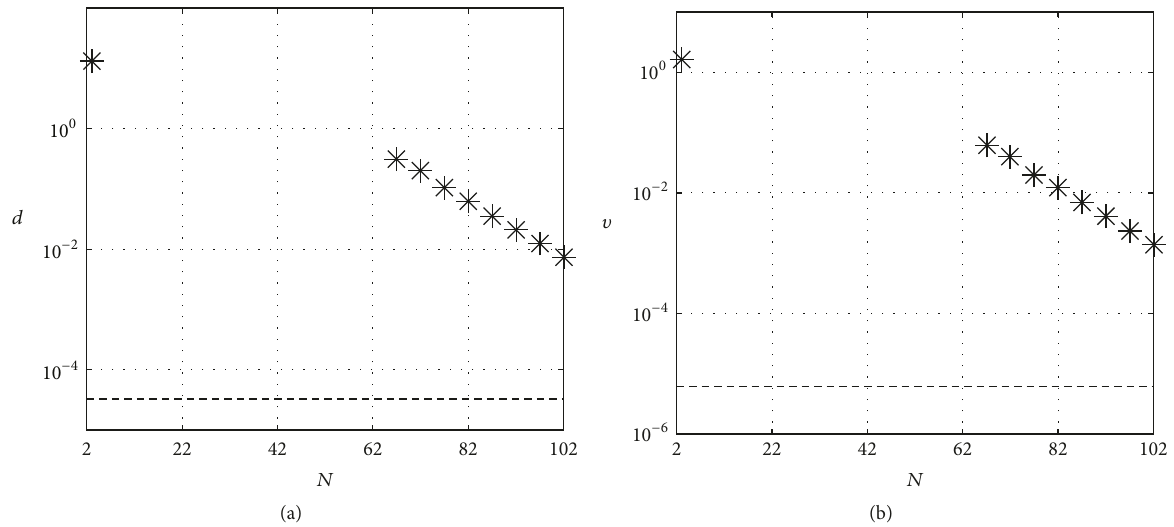
Figure 9: Indexes (a) 𝑑 and (b) 𝜐 when applying aPBC to TUPO1 for different 𝑁 with 𝑘 = 0.25 and 𝑘 𝑜 = 10 . Bottom dashed line are the values of (a) 𝑑 and (b) 𝜐 computed with 𝑁 = 152 and 𝑘 𝑜 = 50 used as reference.